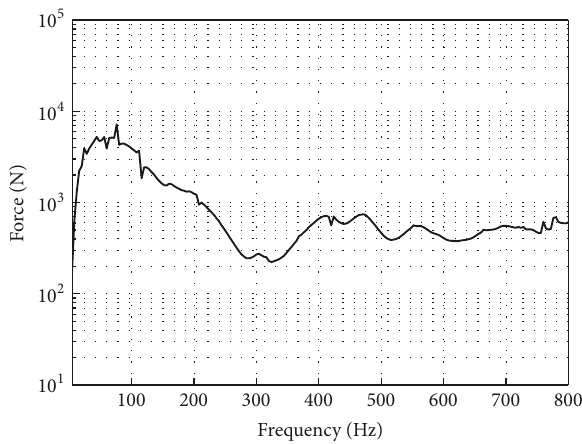
Figure 7: Wheel/rail contact force in frequency domain.